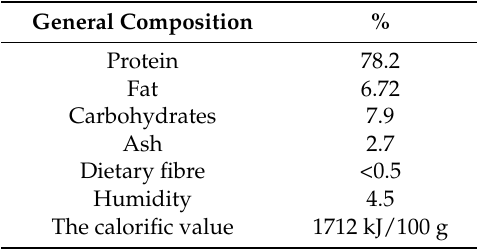
Table 1. General composition of whey protein concentrate